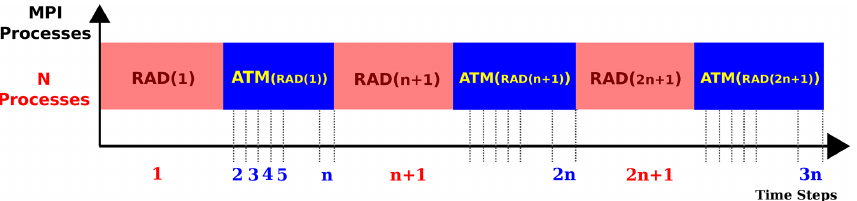
Figure 1. The organization of the classical radiation scheme in ECHAM6: the radiative transfer is resolved sequentially with respect to the other atmospheric physics and dynamics, and it is stepped forward at a slower rate than the other atmospheric processes.